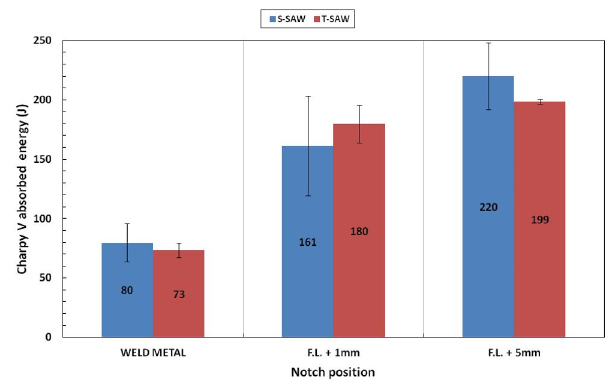
Figure 16: Results of Charpy V tests at 0°C for different regions of the welded joint; weld metal, 1 mm away from the fusion line and 5 mm from the fusion line.